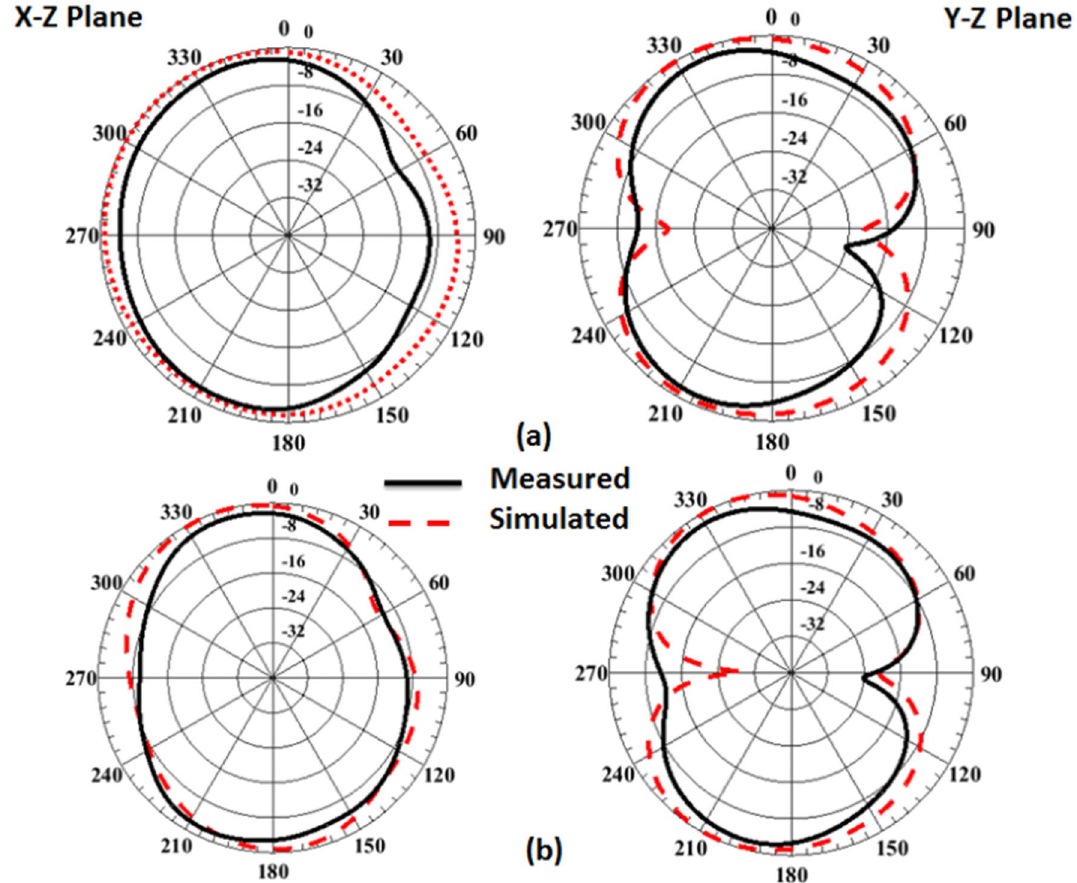
Figure 18. Port #1 radiation patterns simulated and testing outcomes of the flexible MIMO antenna in bending configuration with R = 45 mm ( a ) @4.5 GHz, ( b ) @ 8.5